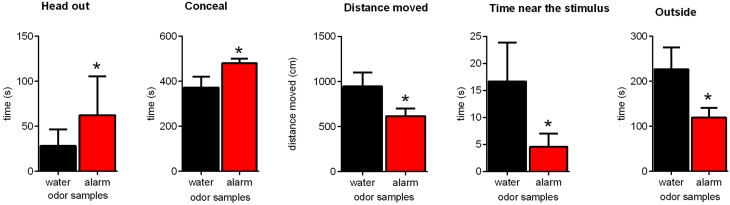
Effects of the alarm pheromone on the behavior of Sprague-Dawley rats. Rats were exposed to either the alarm pheromone (alarm) or water. Data are expressed as means ± SEMs. *p < 0.05, paired t-tests.